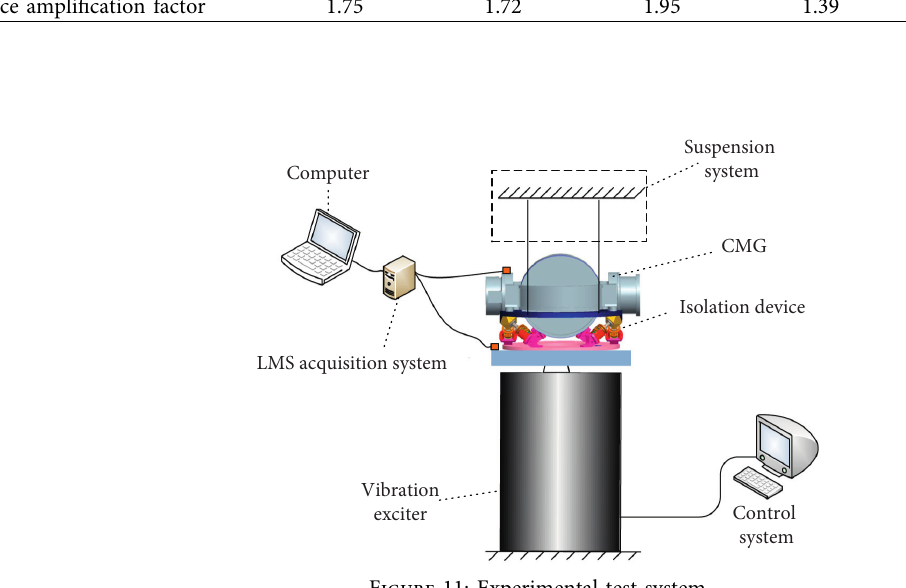
Table 5: Vibration isolation performance of microvibration suppression device in six directions. Direction X Y 100Hz attenuation rate (%)